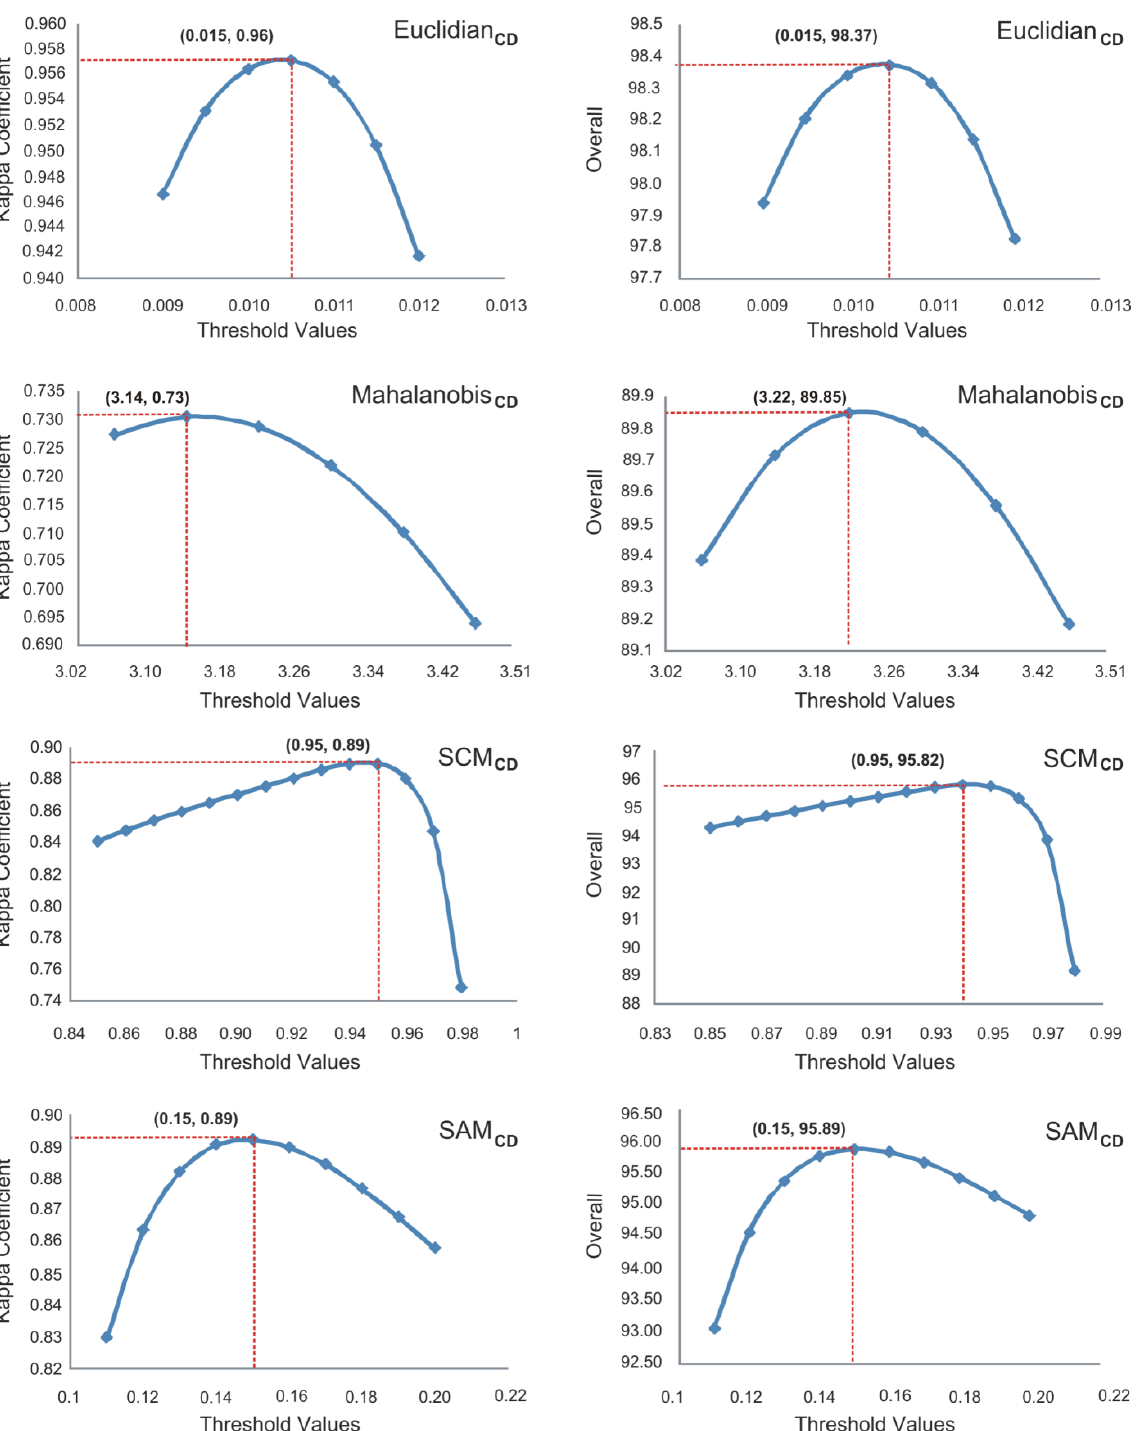
Figure 10. Identification of the optimal threshold values for assessing change images made with the Euclidian distance, Mahalanobis distance, Spectral Correlation Mapper (SCM and Spectral Angle Mapper (SAM ) algorithms from the highest Kappa coefficient and CD Overall